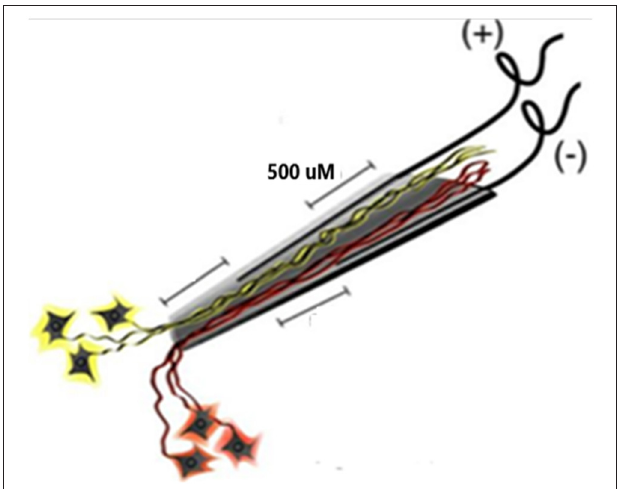
FIGURE 1 | Schematic of the neurotrophic electrode. Ingrowth of neurites is assured by placing trophic factors inside the cone tip prior to implantation. The axons nearest each wire will have opposite polarity during depolarizations.